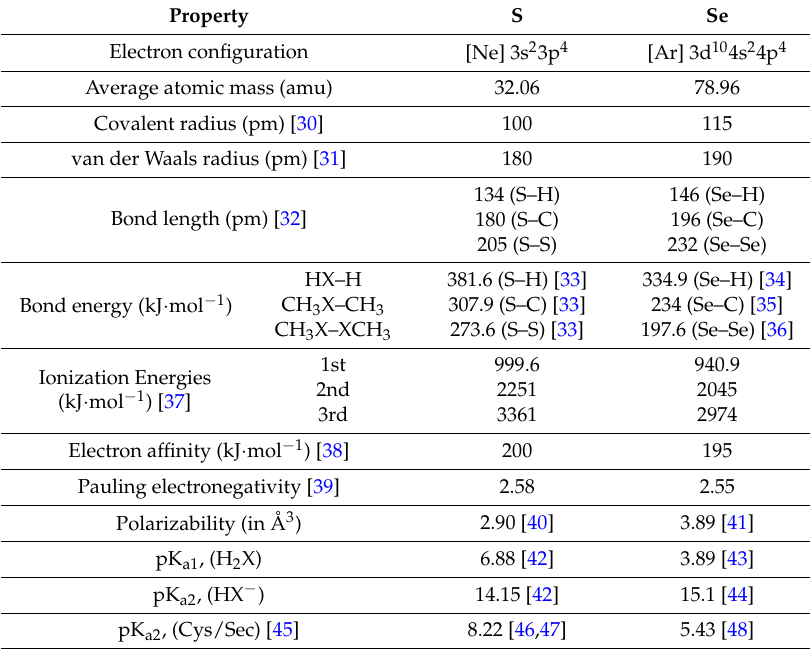
Table 1. General properties of sulfur and selenium.